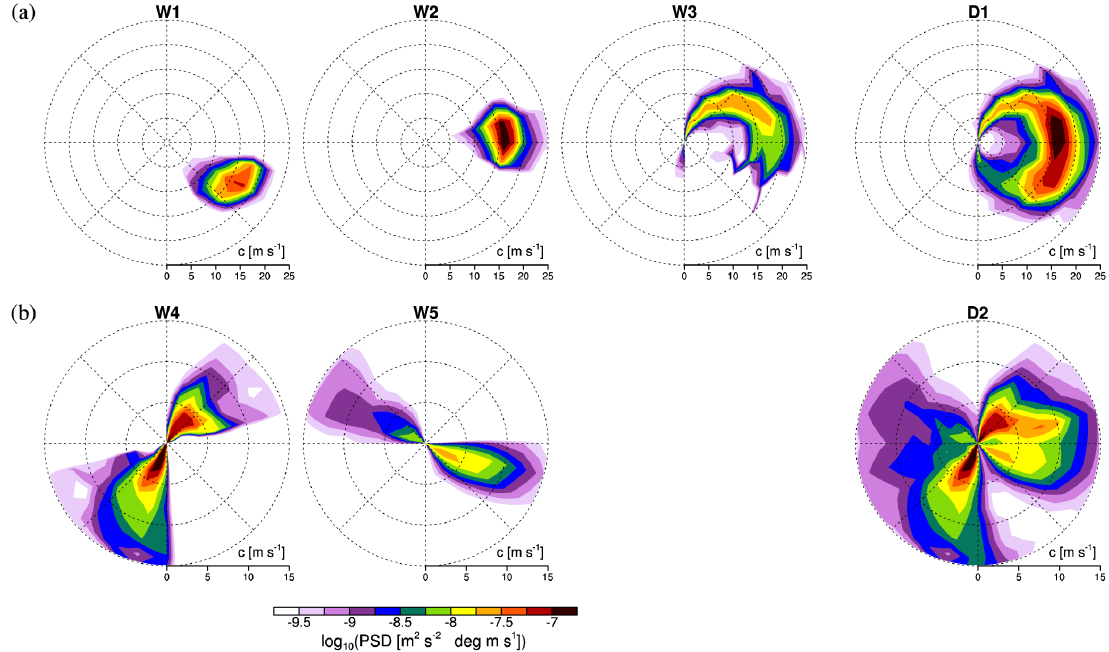
Figure 7. Power spectra of w (cid:48) at z = 8km as a function of phase speed and propagation direction calculated in (a) 48–73 ◦ N, 20–60 ◦ E and (b) 21–46 ◦ N, 20–60 ◦ E. The rightmost panels were obtained using all pairs of (k,l) , and the other panels are for W1, W2, and W3 in (a) and for W4 and W5 in (b)